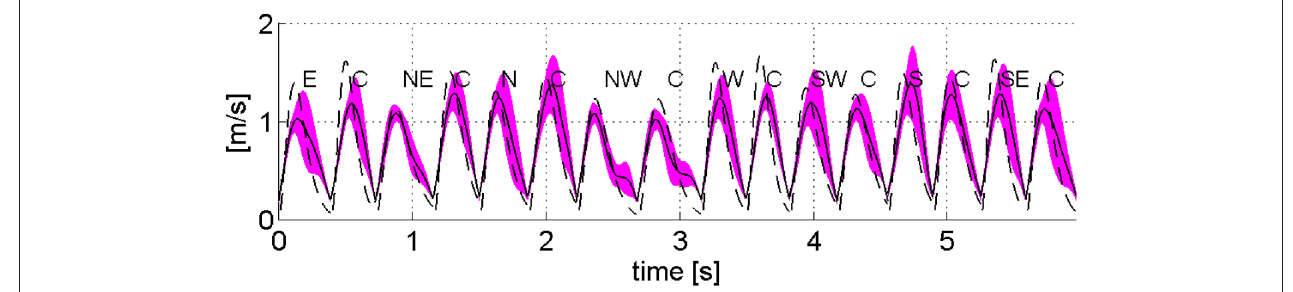
FIGURE 8 | Task space velocity profiles of a representative subject [mean (continuous line) and standard deviation] and those predicted by the λ 0 -PMP (dashed